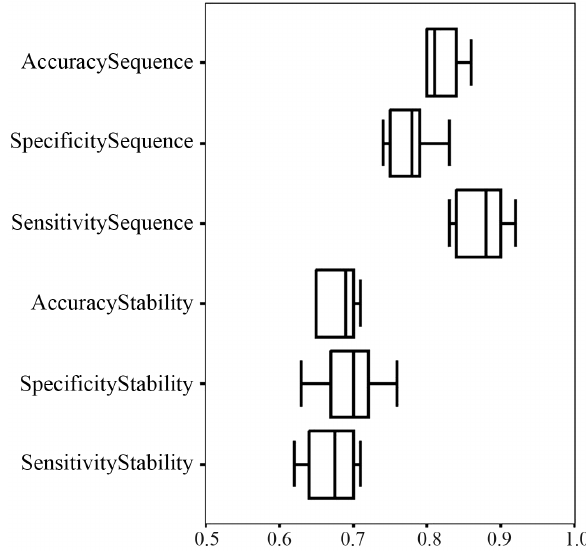
Figure 4 - Box plot for accuracy, specificity and sensitivity in the ten-fold cross-validation for both simulations.